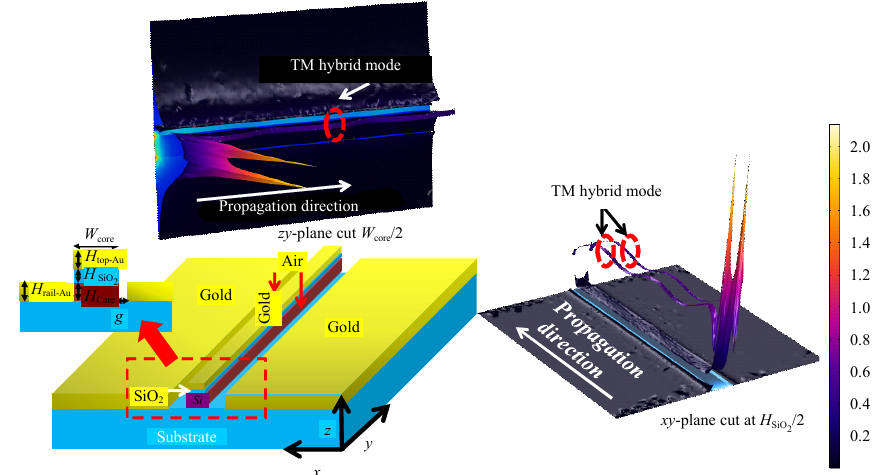
Fig. 1 Graphical representation of the polarization-insensitive HPWG design. Inset shows the 3-dimension (3D) E-field distribution of TE (bottom-right) and TM (top-left) polarized lights in the WG